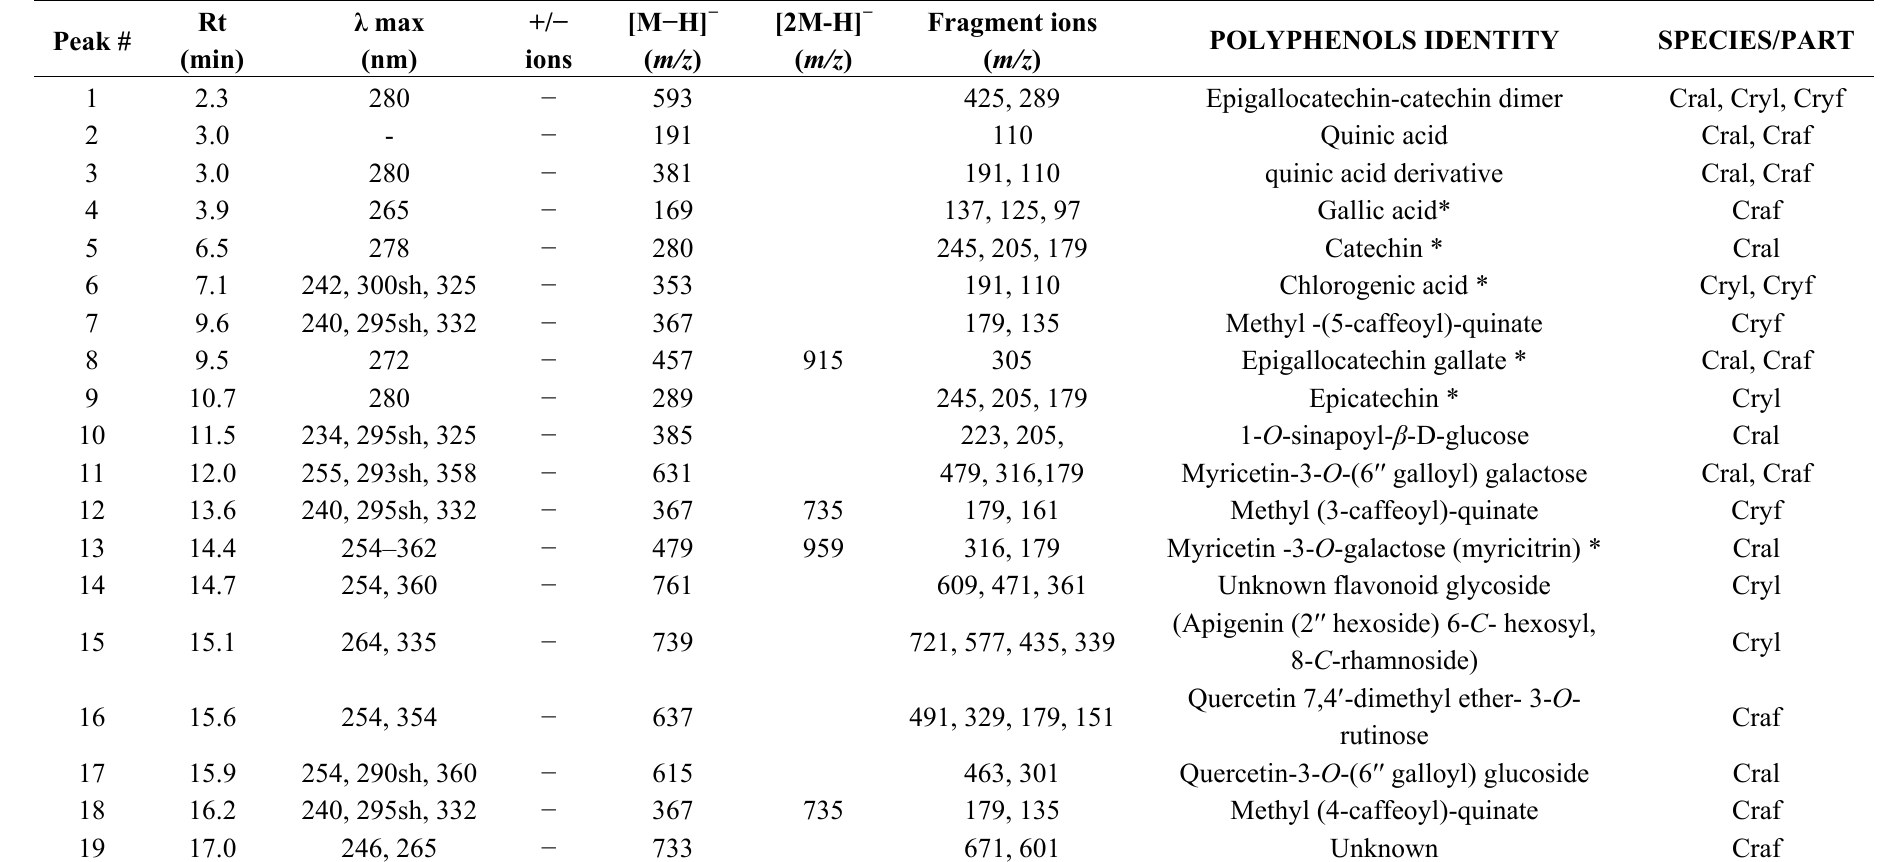
Table 2. Identification of phenolic compounds in peumo fruits and leaves by LC-DAD, LC–MS and MS/MS